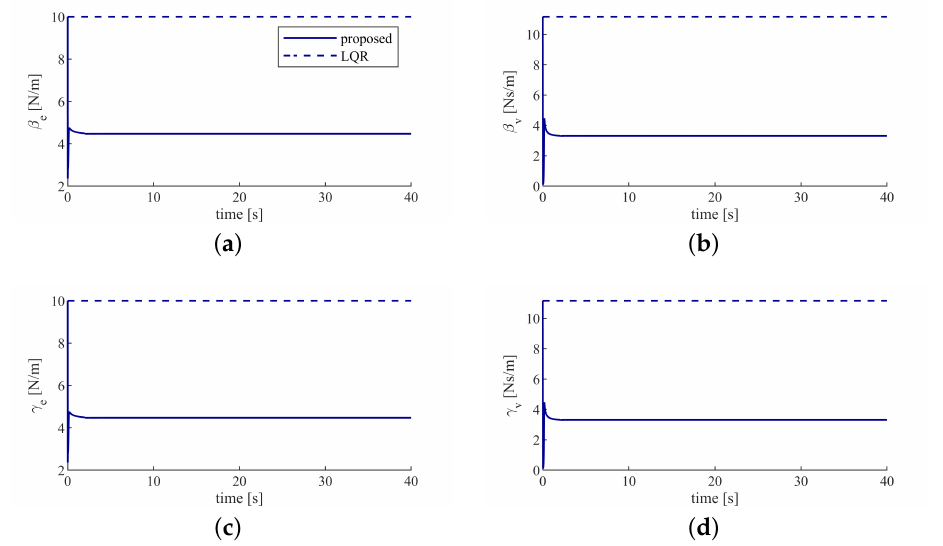
Figure 6. Humans’ control gains ( a ) the position error feedback gain of the human 1. ( b ) the velocity feedback gain of the human 1. ( c ) the position error feedback gain of the human 2. ( d ) the velocity feedback gain of the human